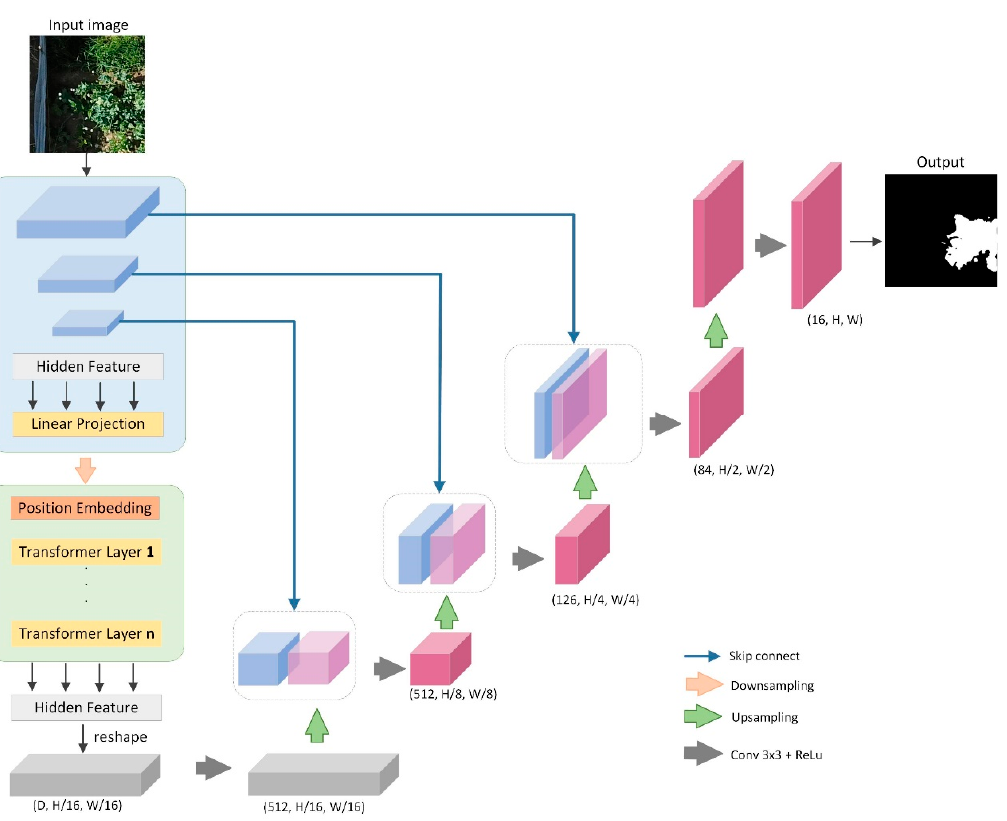
Figure 3. The TAU-Net network